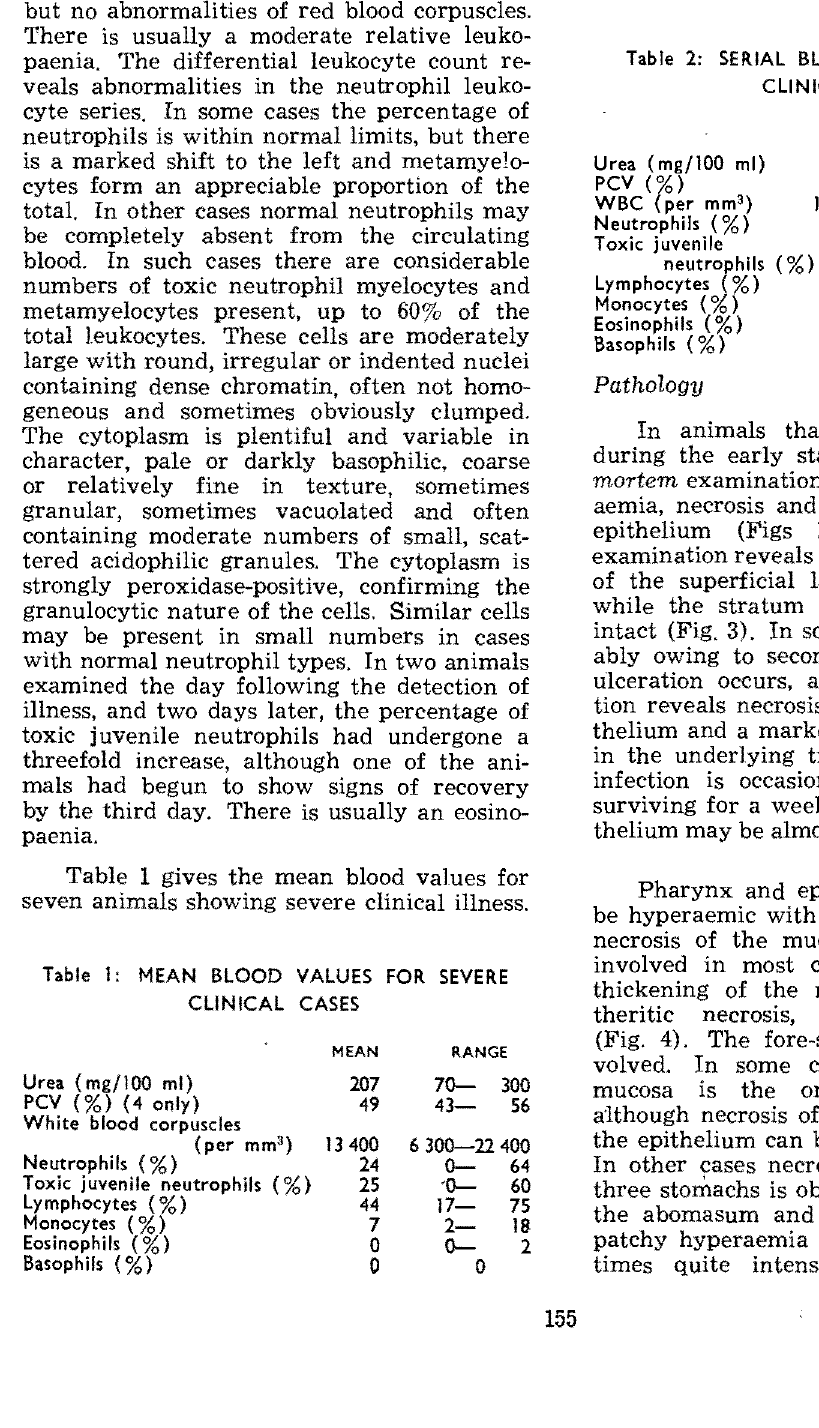
Table 2: SERIAL BLOOD VALUES FOR